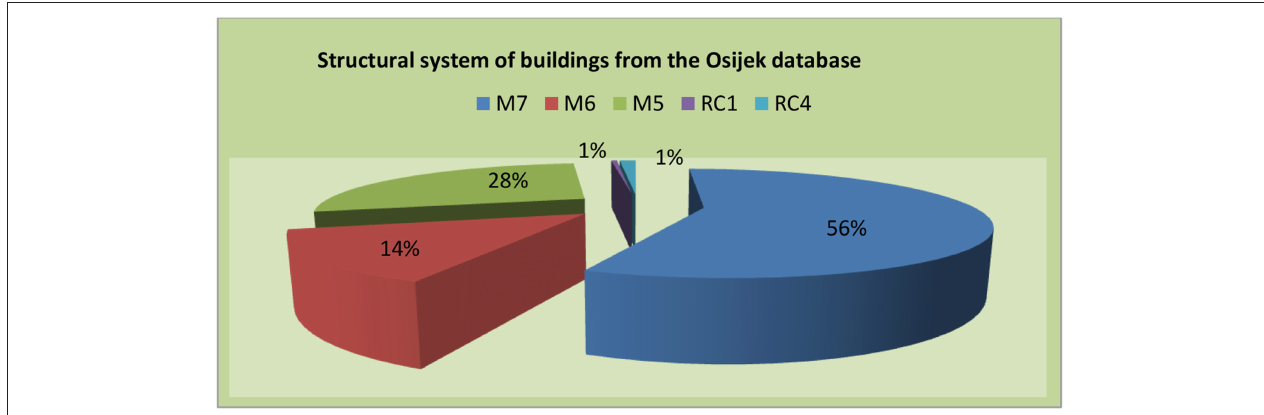
FIGURE 1 | The proportion of structural systems in the so far built Osijek city building database.